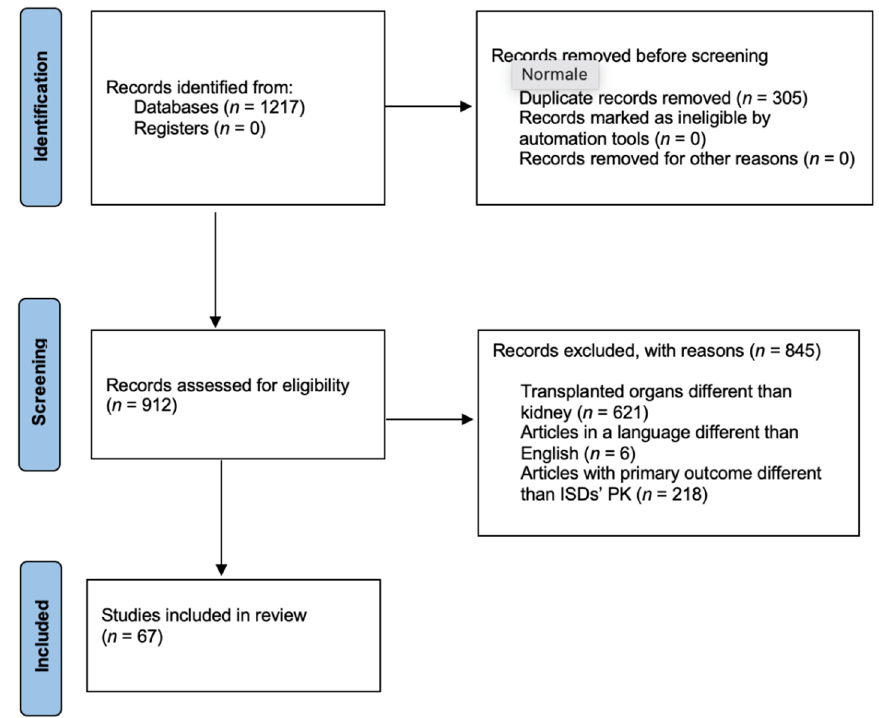
Figure 1. Flow diagram of literature search.